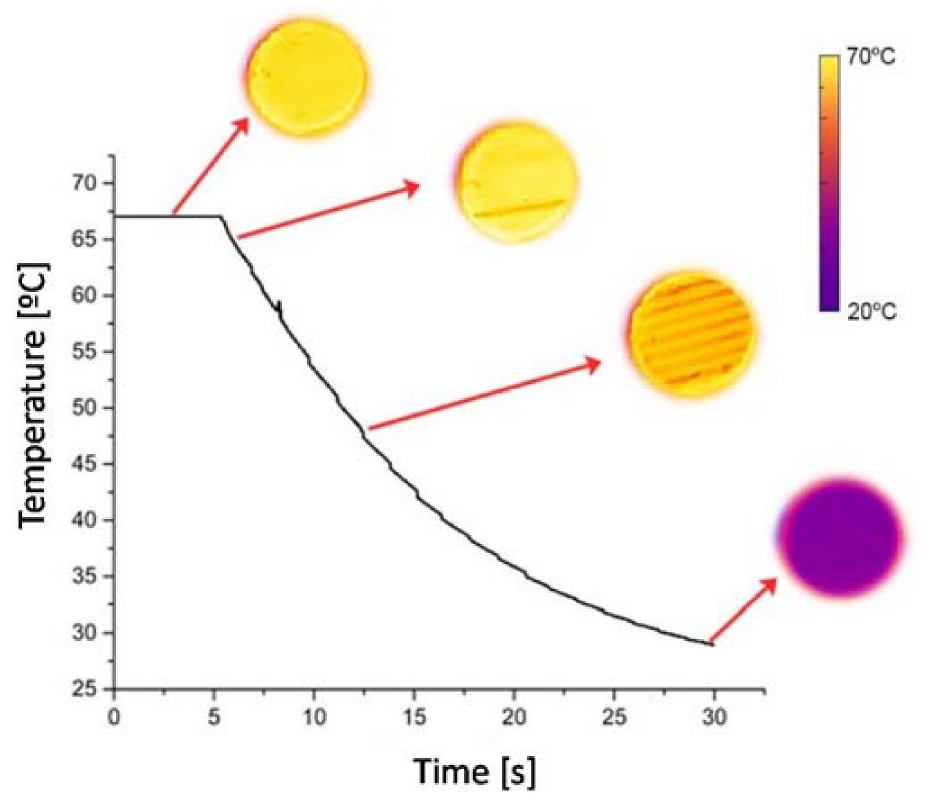
Figure 7. Temperature variation during the cooling process taken with the thermographic high-speed camera for HFE7100 in the heat sink with a 500 µ m channel